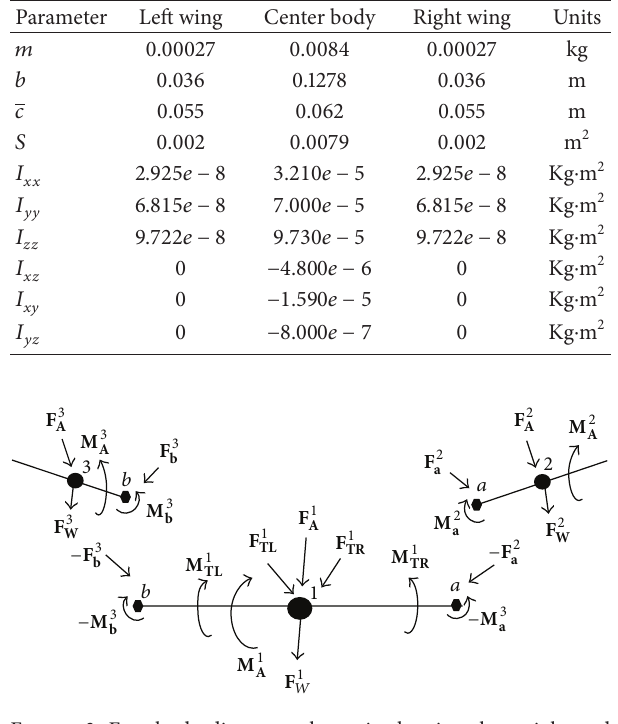
Figure 3: Free body diagram schematic showing the weight and aerodynamic and joint forces and moments acting on the articulated MAV.